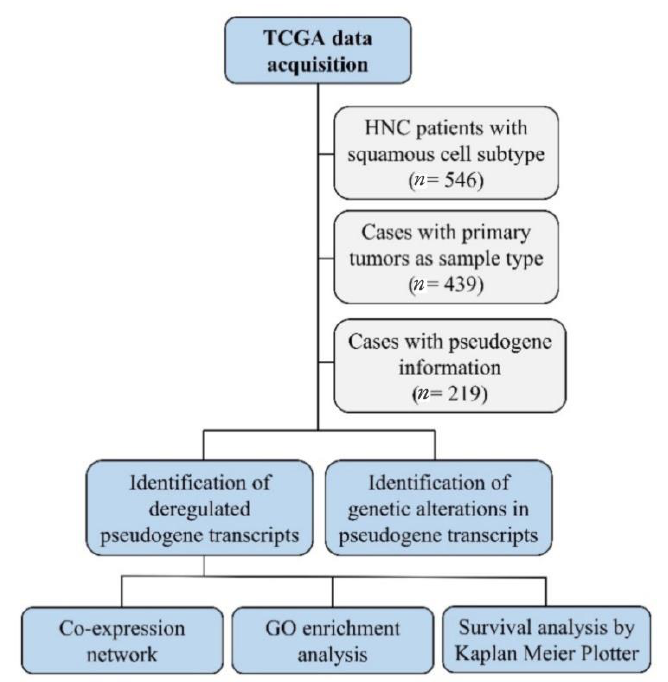
Figure 1. The workflow of the in silico analysis. This strategy detected deregulated pseudogene transcripts in head and neck cancer, their genetic alteration, gene interactions and pathways, and their role in patients’ survival.